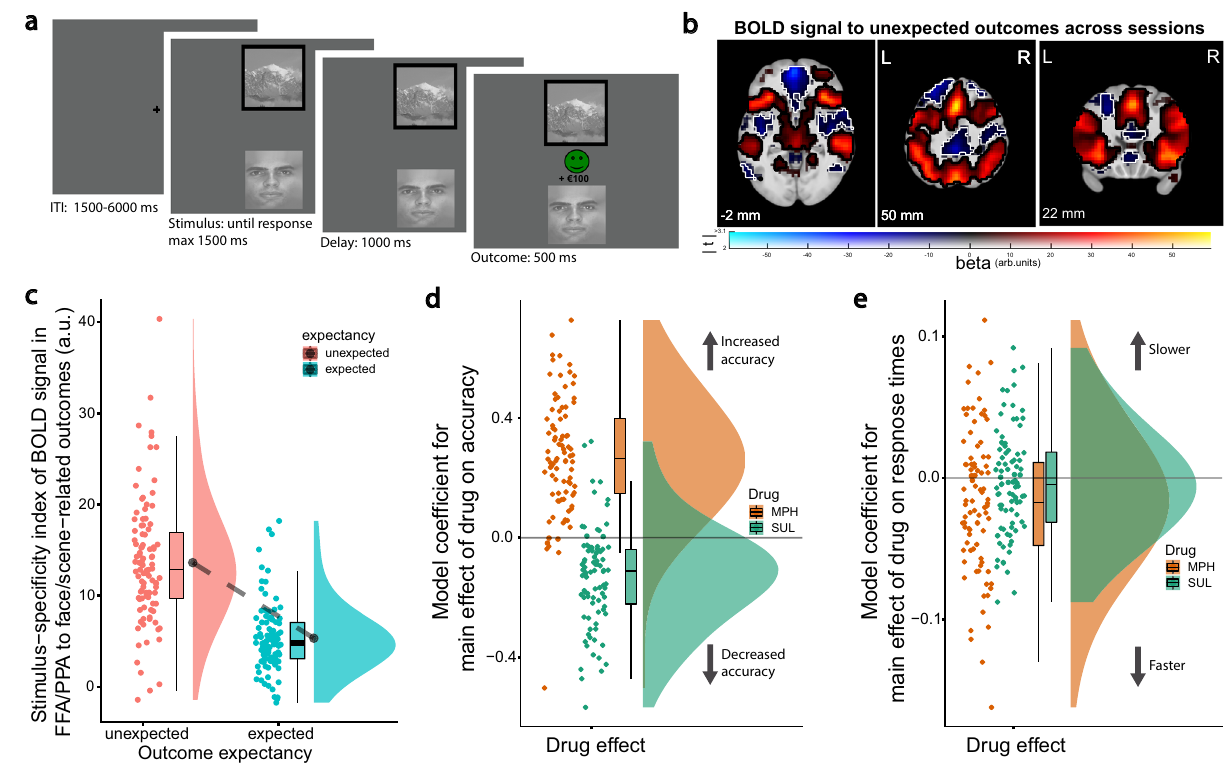
Fig. 1 | Task and main effects. a Reversal-learning paradigm. Two stimuli, a face and a scene, were presented simultaneously. One was associated with a reward outcome, the other with a punishment outcome, with 100% deterministic con- tingencies. On each trial the computer selected one image, and the participant ’ s taskwastopredictwhetherthehighlightedstimuluswouldbefollowedbyareward or punishment outcome. Then the actual outcome was presented. The stimulus- outcome associations reversed regularly, which was signaled by either an unex- pected reward or unexpected punishment outcome. Accuracy on trials immedi- ately after an unexpected outcome (reversal trials) was the performance measure of interest. Task images were obtained with permission from ref. 48. b fMRI BOLD signaltounexpectedversusexpectedoutcomescollapsedacrossallthreesessions ( N =94 participants). In these dual-coded images, color indicates the size of